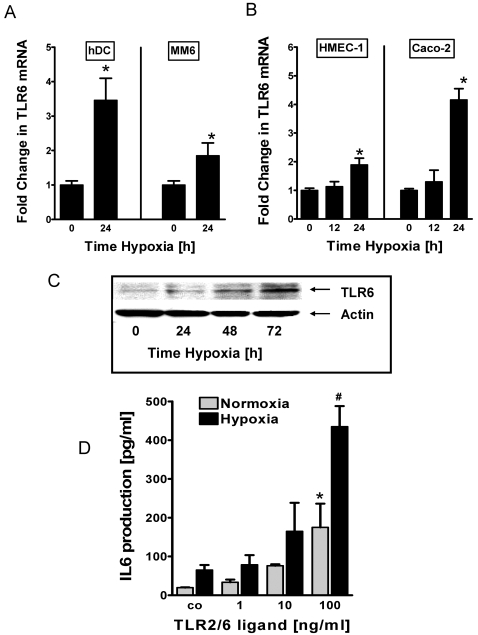
TLR6 transcript, protein and function during hypoxia.
A and B, Quantification of TLR6 transcripit levels in freshly purified blood DCs, MM6 cells, confluent HMEC-1 monolayers and confluent Caco-2 monolayers. Cells were exposed to normoxia and hypoxia for indicated time points. Total RNA was isolated and TLR6 mRNA levels were determined by real-time RT-PCR. Data were calculated relative to ß-actin and expressed as fold change relative to normoxia±SEM, where transcript levels in normoxic cells were normalized to 1. Results are derived from three different experiments. *, significant differences from normoxic cells (p<0.01). C, Confluent HMEC-1 cells were grown to confluence and exposed to indicated periods of hypoxia. Result depicts a representative TLR6 Western blot from three separate experiments. The same blot was probed for ß-actin expression as a control for protein loading. D, Same amount of HMEC-1 cells were grown to confluence in 24-well plates. Cells were then stimulated with TLR2/6 agonist (FSL-1) at the indicated concentrations and exposed to hypoxia or normoxia for 24 h. After 24 h, generation of IL6 was measured by ELISA in the cell supernatant. Data are mean±SEM from 3 separate replicates. *, significant differences from untreated cells (p<0.05); #, significant differences from normoxia and untreated cells (p<0.05).